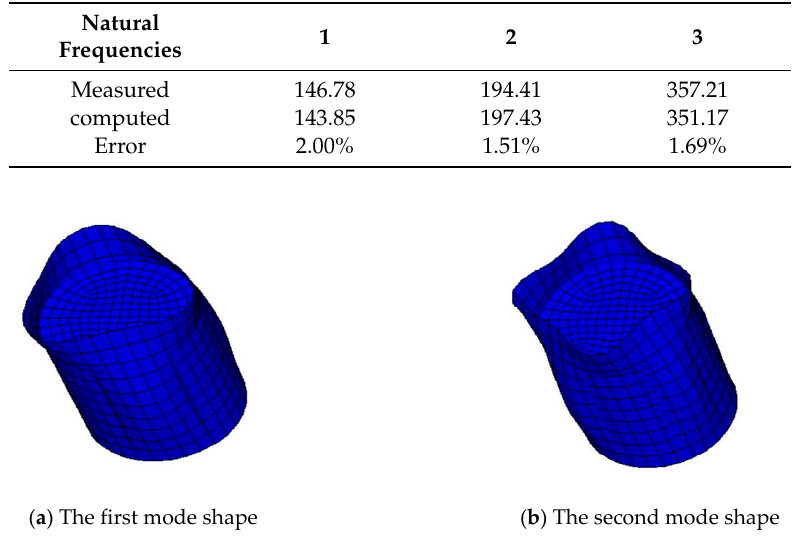
Figure 23. Natural frequency domain response of acceleration and pulse load.